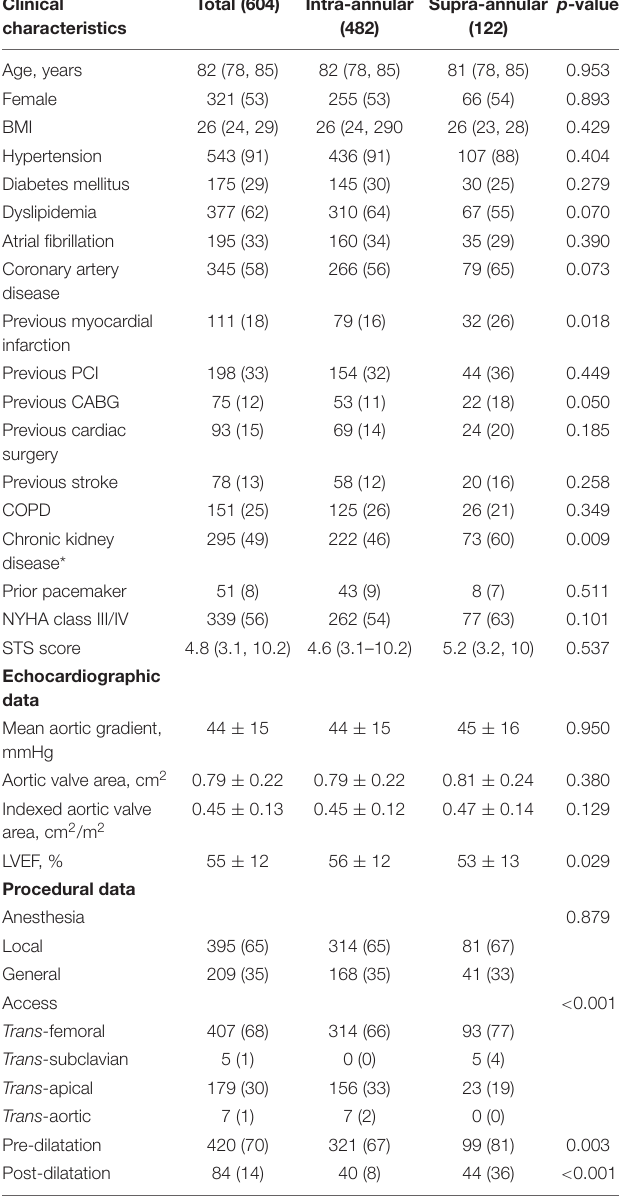
TABLE 1 | Baseline